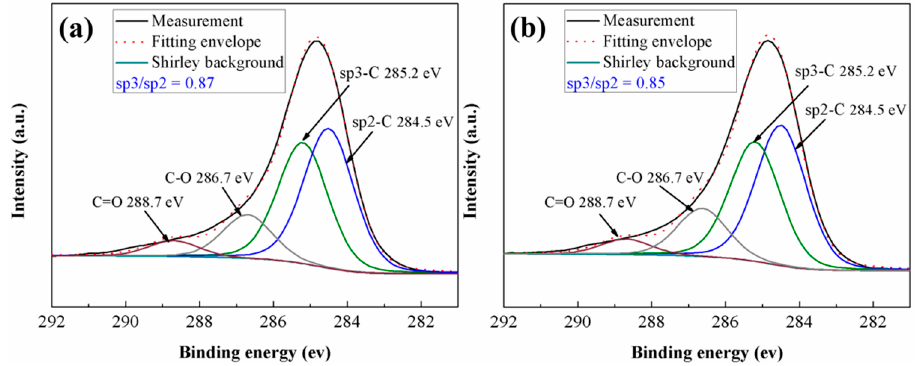
Figure 9. The fitting results of the C1s peak in XPS spectra of: ( a ) as-deposited a-C; and ( b ) the worn a-C surface under the lubrication of ZrO 2 -NPs dispersion.